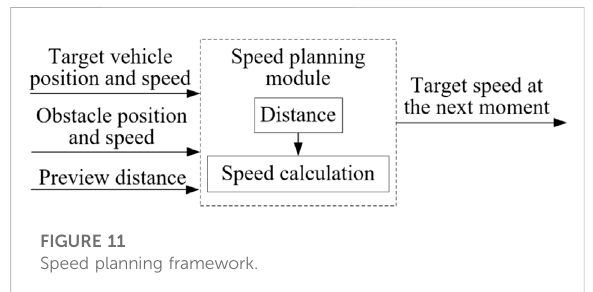
FIGURE 11 Speed planning